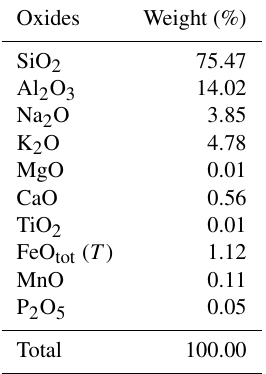
Table 1. Average normalized chemical analysis of Ramadas obsid- ian rocks from Gauthier